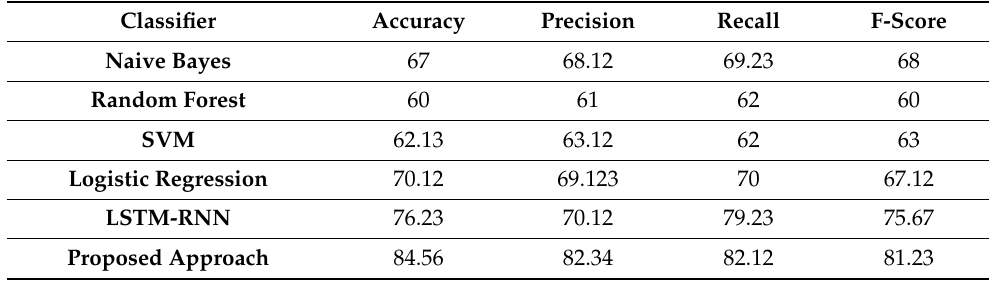
Table 6. Results of the proposed approach in comparison to other existing approaches.